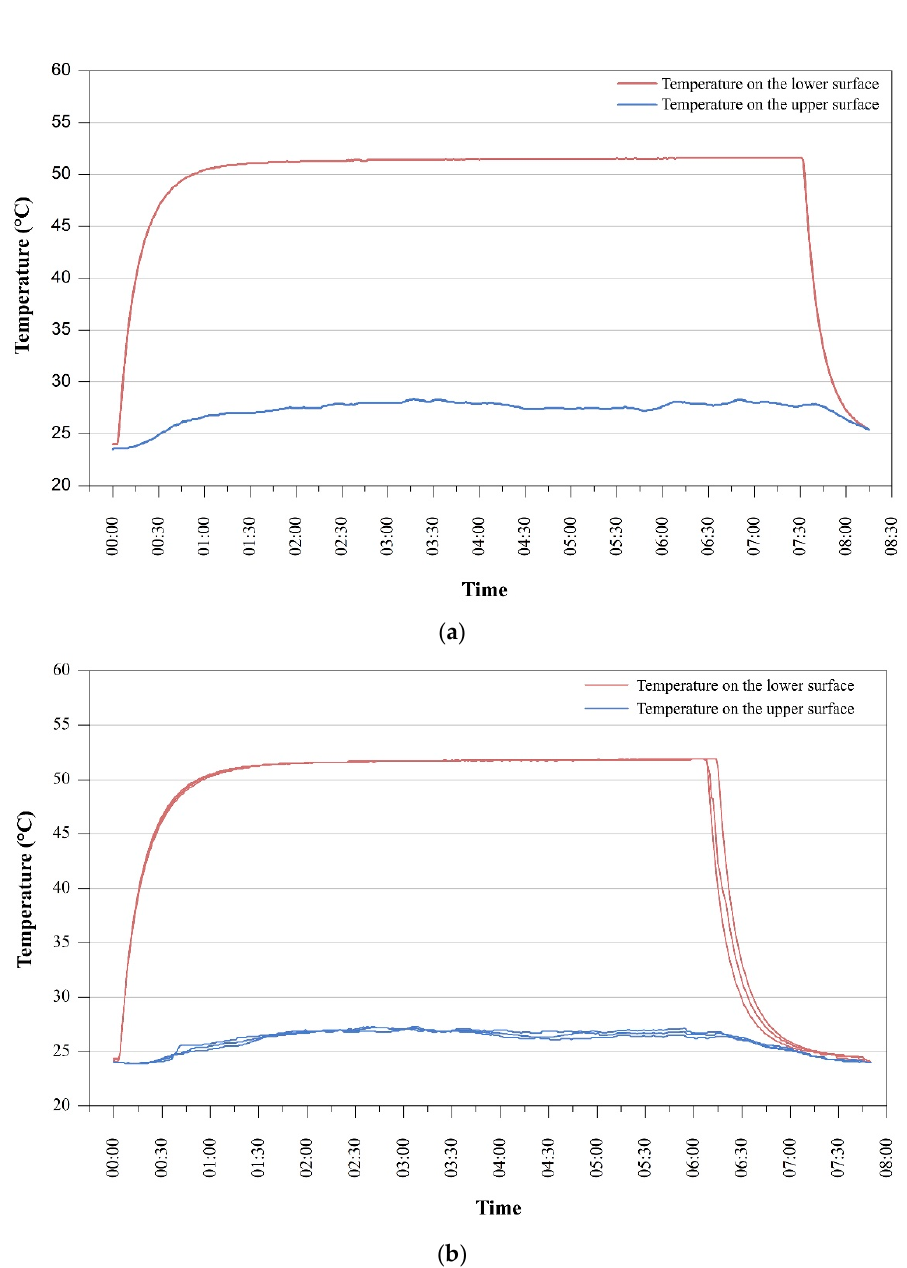
Figure 10. Temperature variation on the upper and lower surface of the samples: ( a ) EPS and ( b ) Buriti foam.